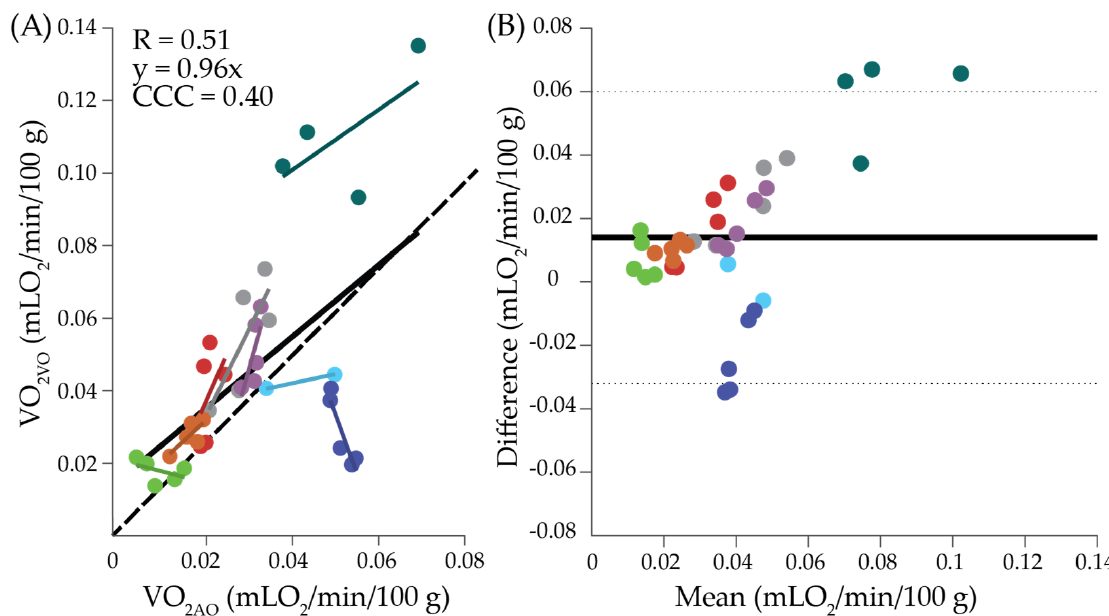
Figure 2. Comparison of oxygen metabolism measured with NIRS during venous and arterial occlusion. ( A ) Oxygen metabolism measured during arterial occlusion (VO 2AO ) versus oxygen metabolism measured during venous occlusion (VO 2VO ) at the 3.5-cm source-detector separation. The solid black line indicates the overall linear fit for the group data. Colored lines indicate linear fit for individual participants. The dashed line denotes the line of unity. ( B ) Bland–Altman plot of the mean of VO 2AO and VO 2VO versus the difference. The solid horizontal line indicates the mean difference, and the dotted lines indicate the 95% limits of agreement. In both figures, data are color-coded by participant.